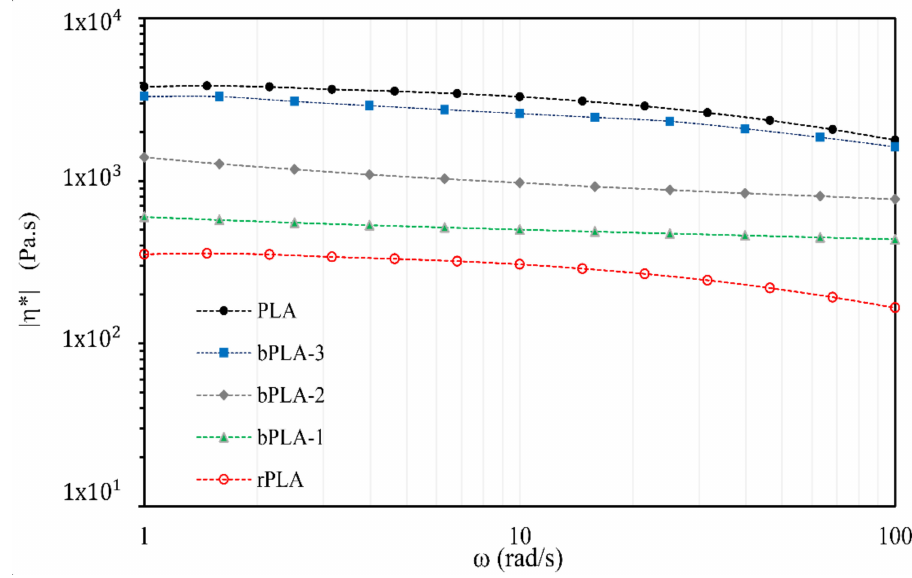
Figure 10. Complex viscosity of rPLA and bPLA